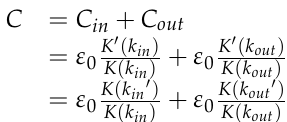
Table 2. The successive coordinate transformations of the inclined plate.